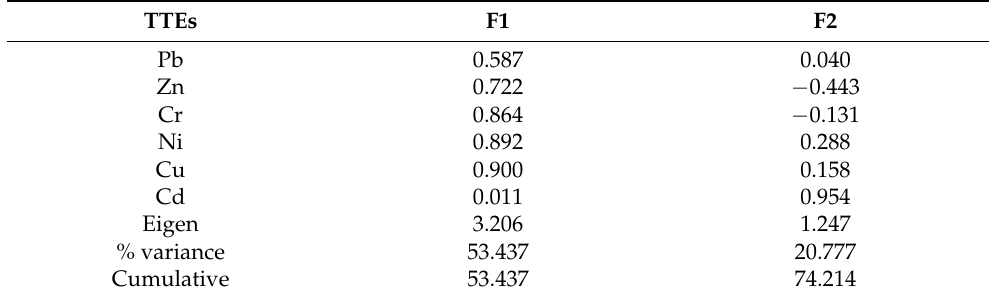
Table 4. Results of principal component analysis of the soil samples of the Makarwal region. TTEs F1